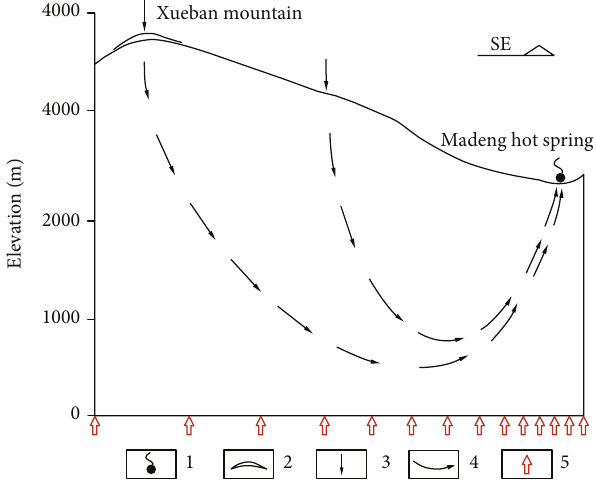
Figure 6: Schematic diagram showing the formation (a regional scale) of the Madeng hot spring in Jianchuan county, Yunnan. 1 — hot spring; 2 — snow and ice; 3 — meteoric water; 4 — fl ow line; 5 — heat fl